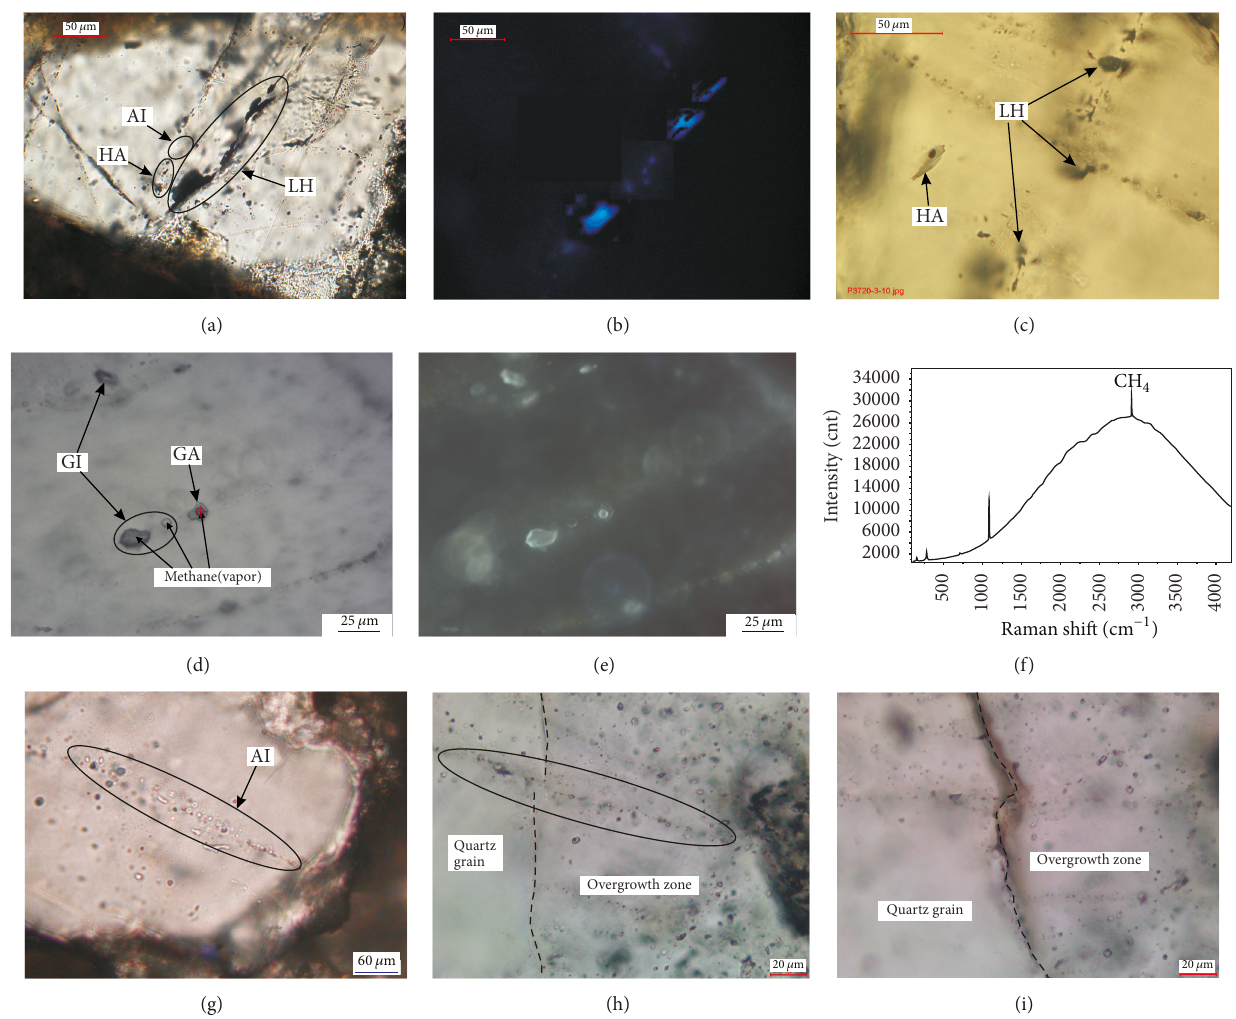
Figure6:(a)LHinclusionscoexistingwithHAandAIinclusionsoccurringalonghealedmicrofracturesinquartzgrain.(b)Bluefluorescence color of LH and HA inclusions shown in Figure 6(a). (c) LH and HA inclusions with elliptical shapes in carbonate cement. (d) Coexistence of GI and GA inclusions in carbonate cement. (e) Yellowish-white fluorescence color of GI and GA inclusions in carbonate cement. (f) Vapor composition of GA inclusion analyzed by Raman spectrum (red cross in Figure 6(d) represents measurement point). (g) Linear group of AI inclusions occurring along healed microfracture in quartz grain. (h) Linear group of AI inclusions occurring along unhealed microfracture cross-cutting quartz overgrowth zone. (i) Random distribution of AI inclusions in quartz overgrowth zone. Table 4: Microthermometric and salinity data of fluid inclusions in ore-bearing rocks within the Mengqiguer uranium deposit. Mineral Host site Type Number